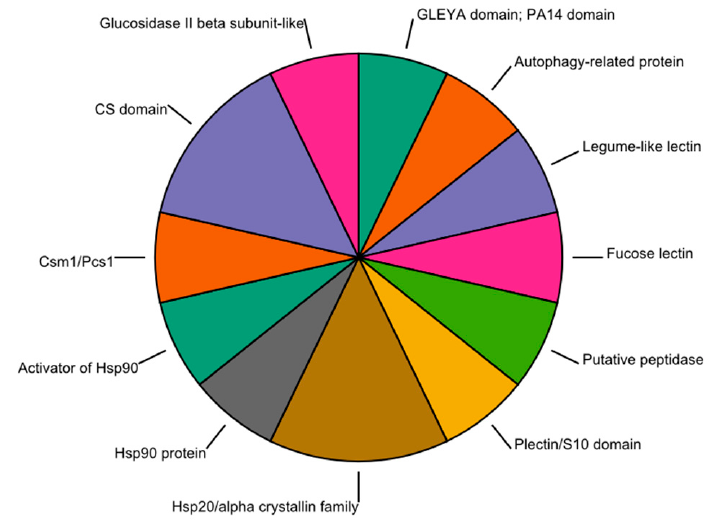
Figure 2. Enzymes directly involved in the adhesion and recognition stages of the infection process of the insect (ant) by the fungus. Each sector proportionally represents distinct groups (based on their specific protein domains) of potentially secreted enzymes.